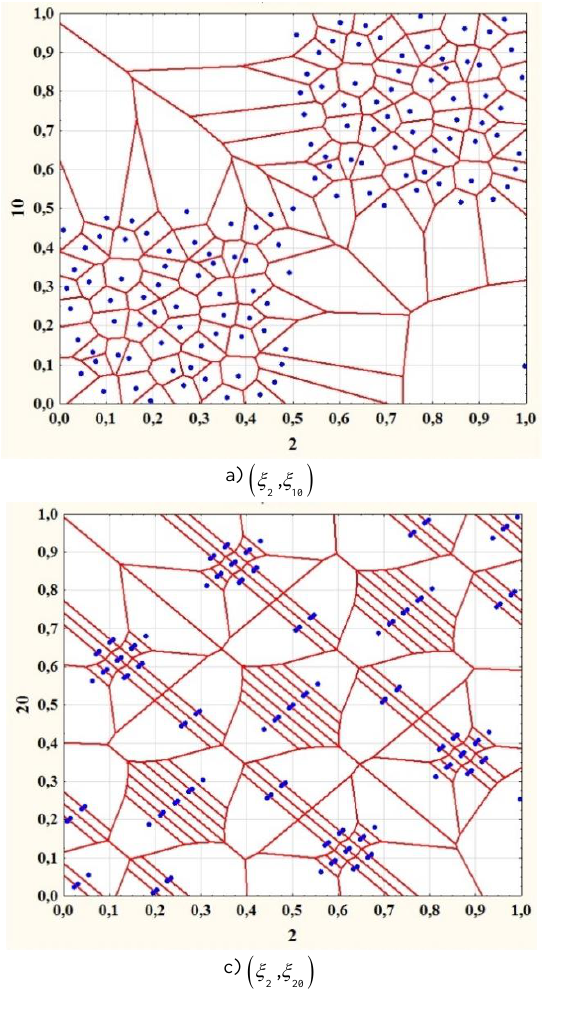
Fig. 2. Visual analysis of the uniformity of two-dimensional designs in the form of Voronoi diagrams formed by LP τ